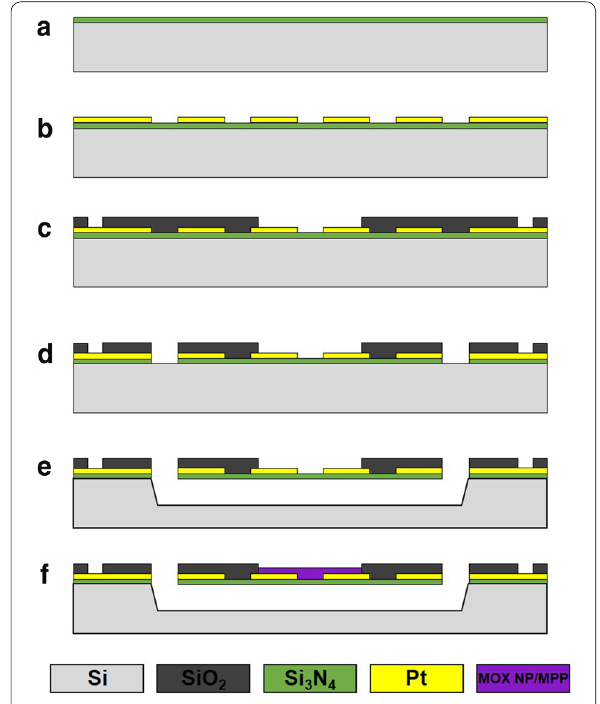
Fig. 2 Fabrication process flow. a Si 3 N 4 film deposition on Si wafer. b Pt deposition and patterning. c SiO 2 deposition and patterning. d Si 3 N 4 /SiO 2 etching to form via hole. e Si wet-etching using TMAH. f Coating of sensing